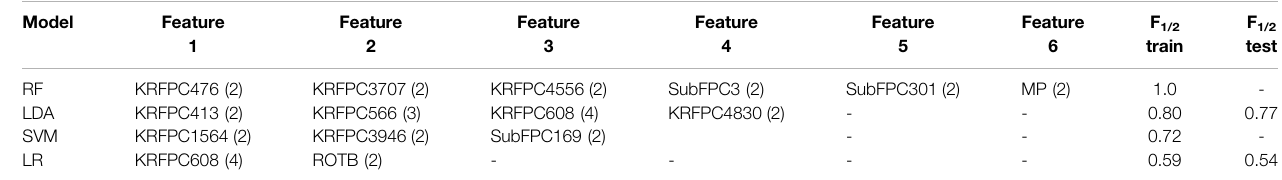
TABLE 3 | Repeated features across different partitions for the fi rst run of the GA ( “ Common features ” , see Figures 2 , 3 ) using different ML models. The frequency each feature is repeated within partitions is shown in paretheses. The F 1/2 Train and F 1/2 Test columns refer to the average score across the different training folds and test folds,